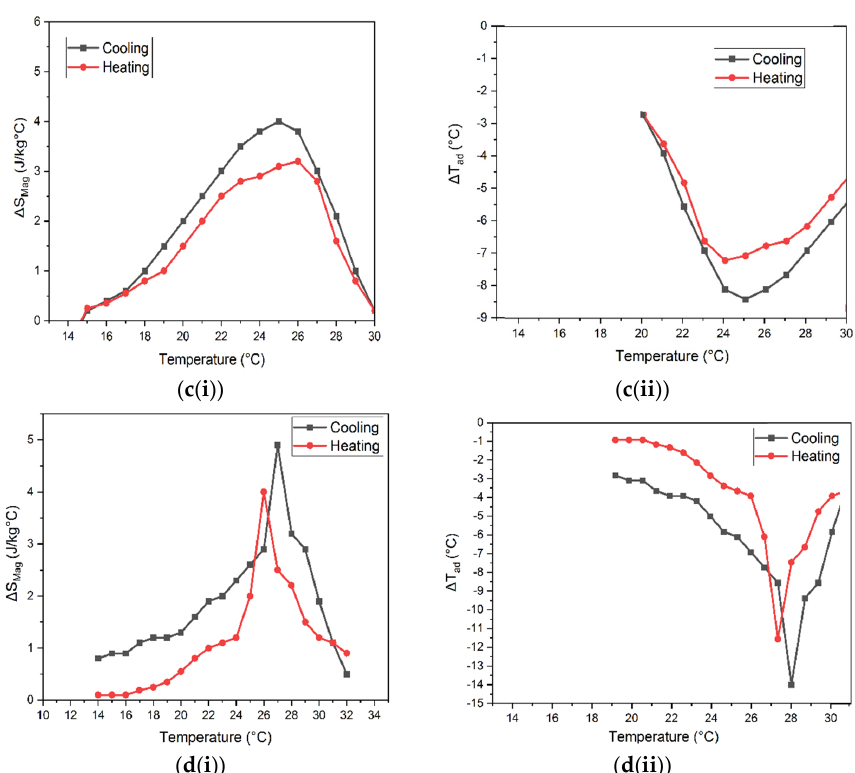
Figure 4. Field dependence inverse magnetocalory for alloys where for Ni 50 − x Fe x Mn 30 Sn 20 − y In y , 1 ≤ x ≤ 4; 2 ≤ y ≤ 8 alloy and ( a ) x = 1, y = 2; ( b ) x = 2, y = 4; ( c ) x = 3, y = 6; and ( d ) x = 4, y = 8, and i and ii represent Δ S m and Δ T ad , respectively.